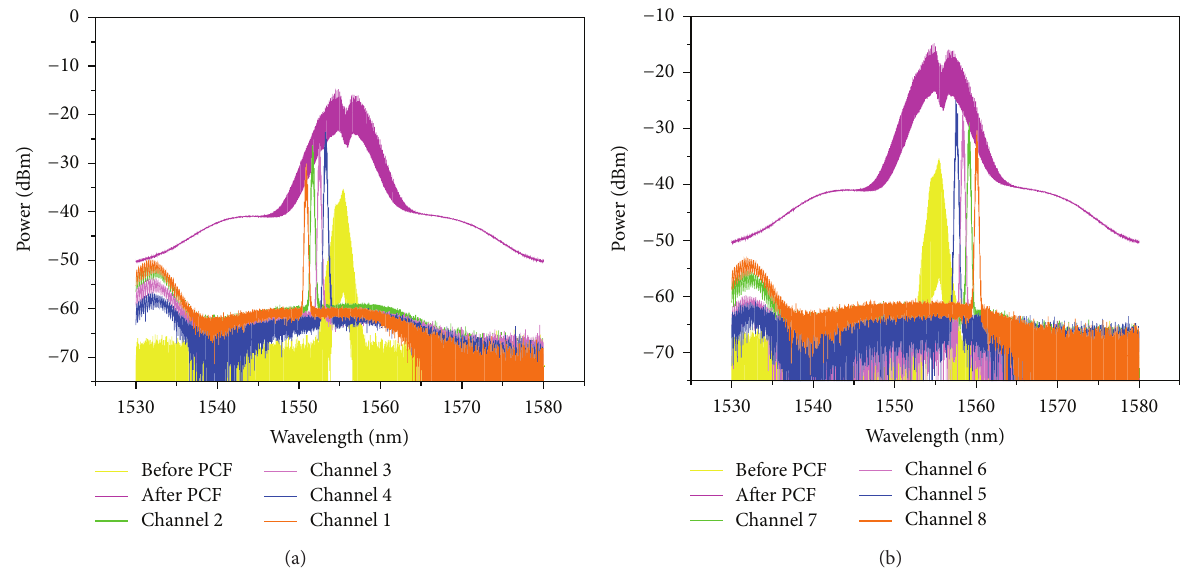
Figure 3: Optical spectrum measured at the input, the output of PCF, and the output of OBPF for (a) left sideband and (b) right sideband.